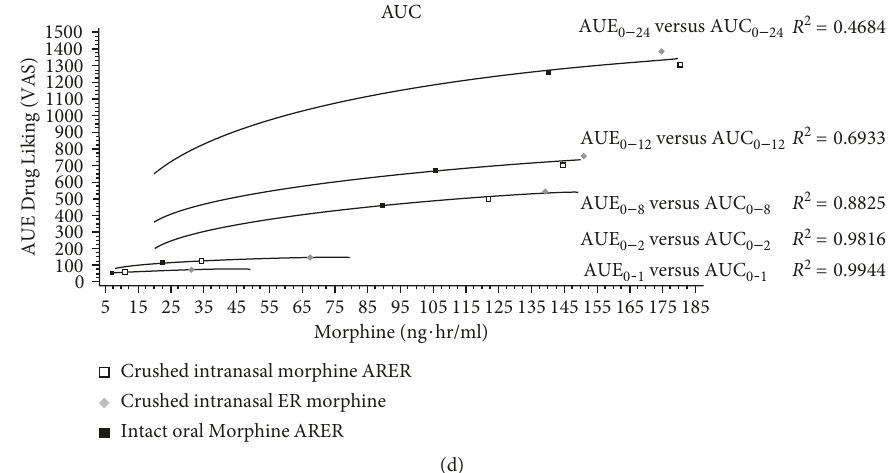
Figure 4: Average time-curve plot of AUE (0-1h, 0–2 h, 0–8h, 0–12h, and 0–24h) for drug-liking VAS versus (a) C and (d) AUC (0-1h, 0–2h, 0–8 h, 0–12h, and 0–24h) (PD population, N curve, AUC area under the plasma concentration-time curve, C max (cid:30) C max , and VAS visual analog (cid:30)